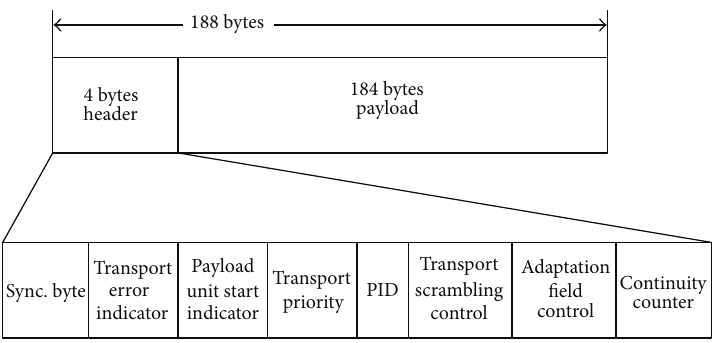
Figure 2: Structure of the MPEG-2 Transport Stream